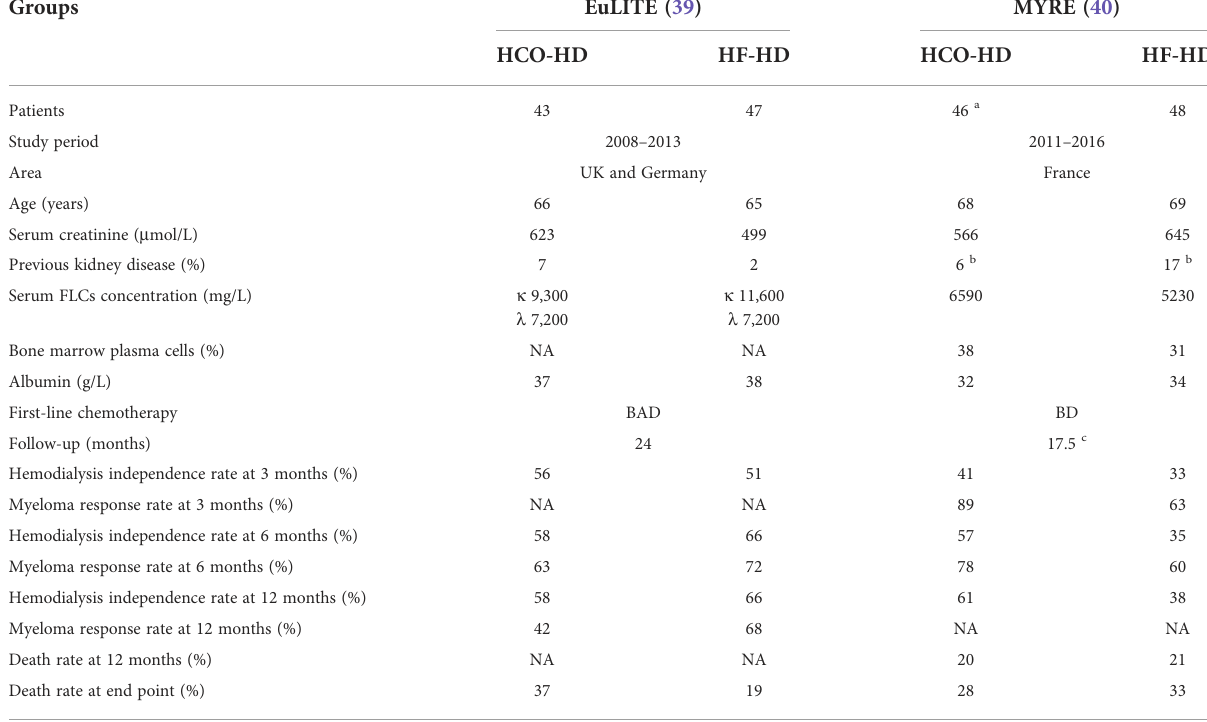
TABLE 2 The major results of the two randomized controlled trials.